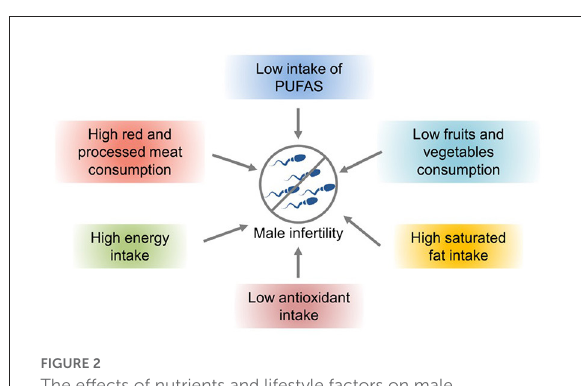
FIGURE2 The effects of nutrients and lifestyle factors on male infertility